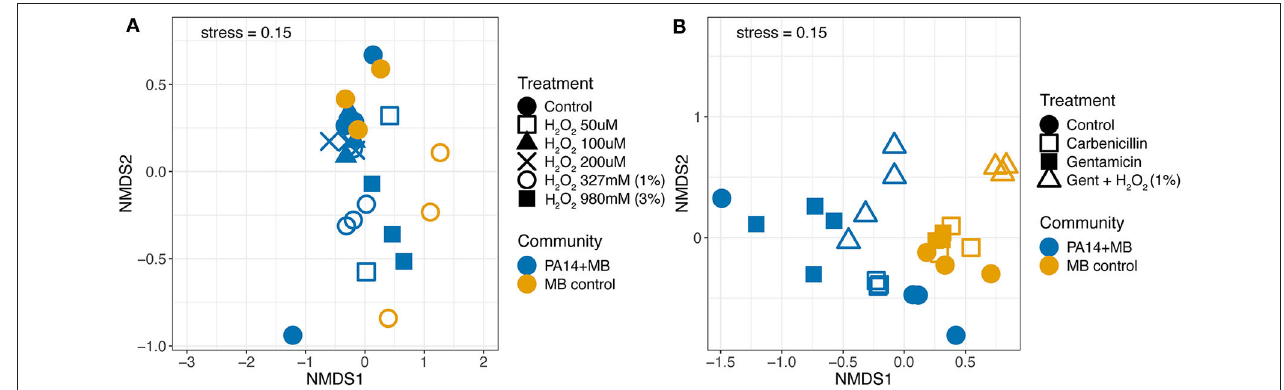
FIGURE 5 | Non-metric multidimensional scaling (NMDS) plot of volatile signatures from the perfusion model from (A) hydrogen peroxide conditions and the control and (B) the antibiotic conditions and the control. The PA14 + MB community represents the microbial community on a meat sample with both PA14 and MB(PA14) populations. The MB control community is a meat sample with only the meat microbial background. Each point represents an individual sample. N ≥ 3 biological replicates for all treatments.